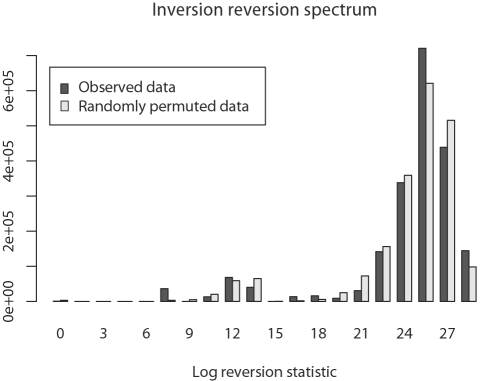
Testing whether inversions are immediately reverted by a second inversion with approximately identical endpoints.Shown is the distribution of statistics described in Equation 6 for consecutive inversions in the posterior distribution of inversion histories (dark gray) and null expectation by randomly paired endpoint distances (light gray). If selection or a recombination bias favoring immediate reversion of imbalanced replichores explains the tendency towards balance, we would expect to see consecutive inversions sharing approximately equal endpoints more frequently than by chance alone. The difference between observation and null expectation is not significant (see text).